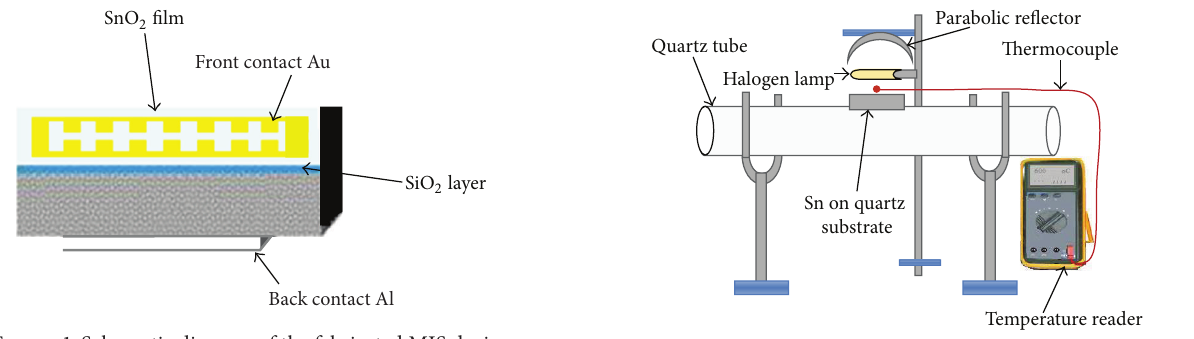
Figure 2: Rapid photothermal oxidation (R.T.O)